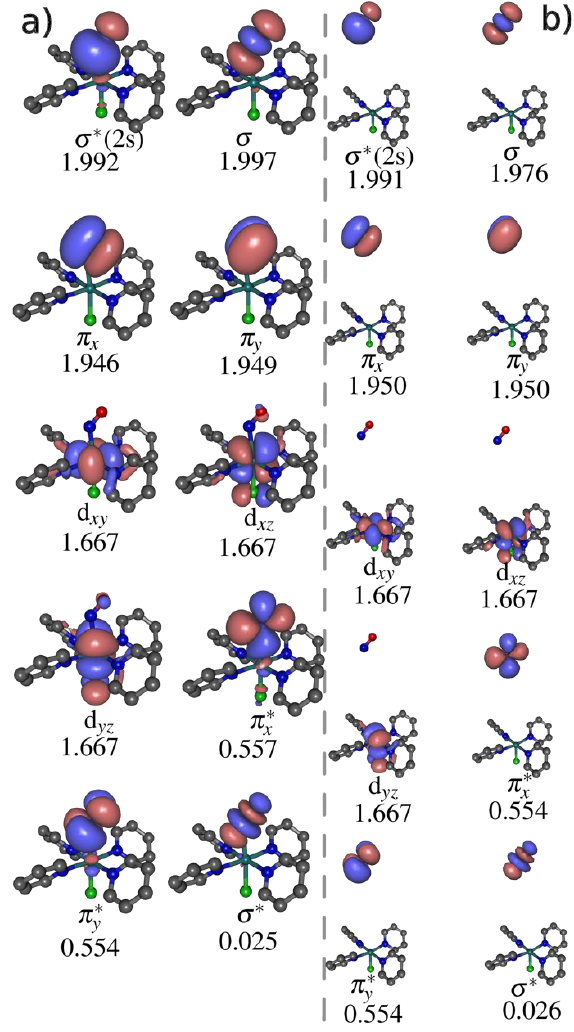
Figure 5. SA6-CASSCF(14,10) active space orbitals for the 3 GS isomer, and their respective average occupation numbers for the triplet states ( a ) at the 3 GS minimum and ( b ) at the asymptotic region.